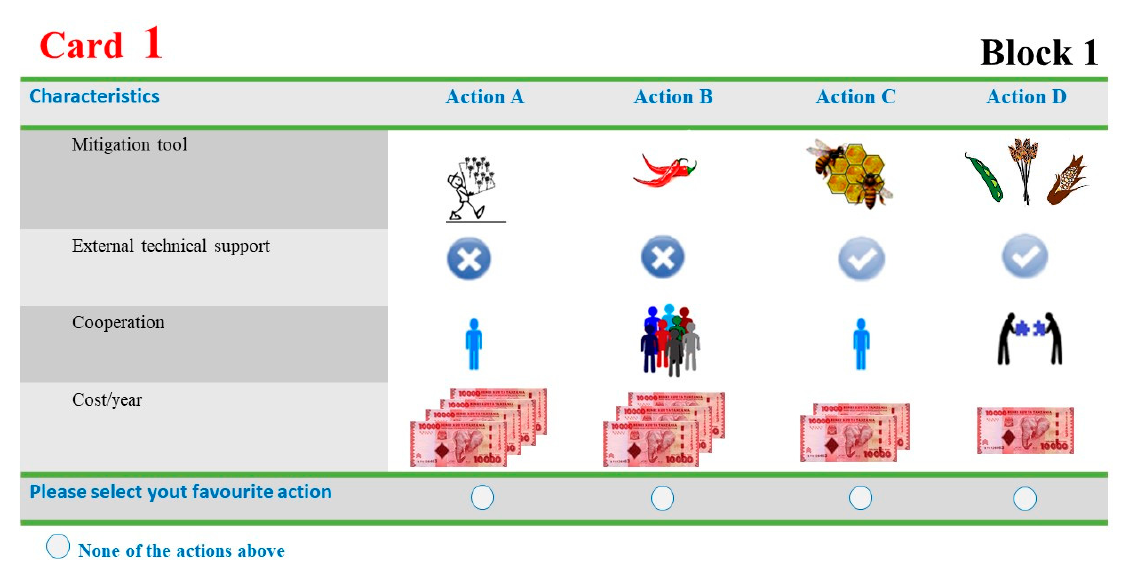
Figure 3. Example of a choice card used in the DCE.